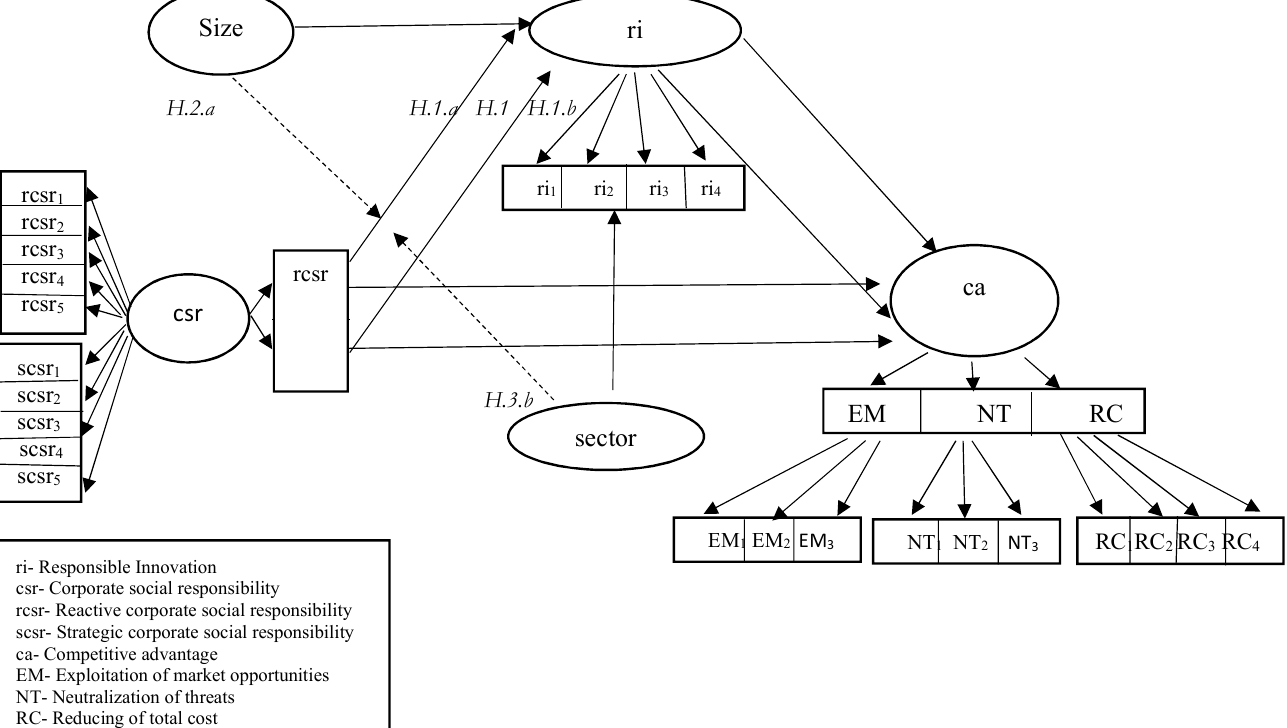
Table 2: Summary statistics Fig. 5. Degree of relationship between CSR, responsible innovation and competitive